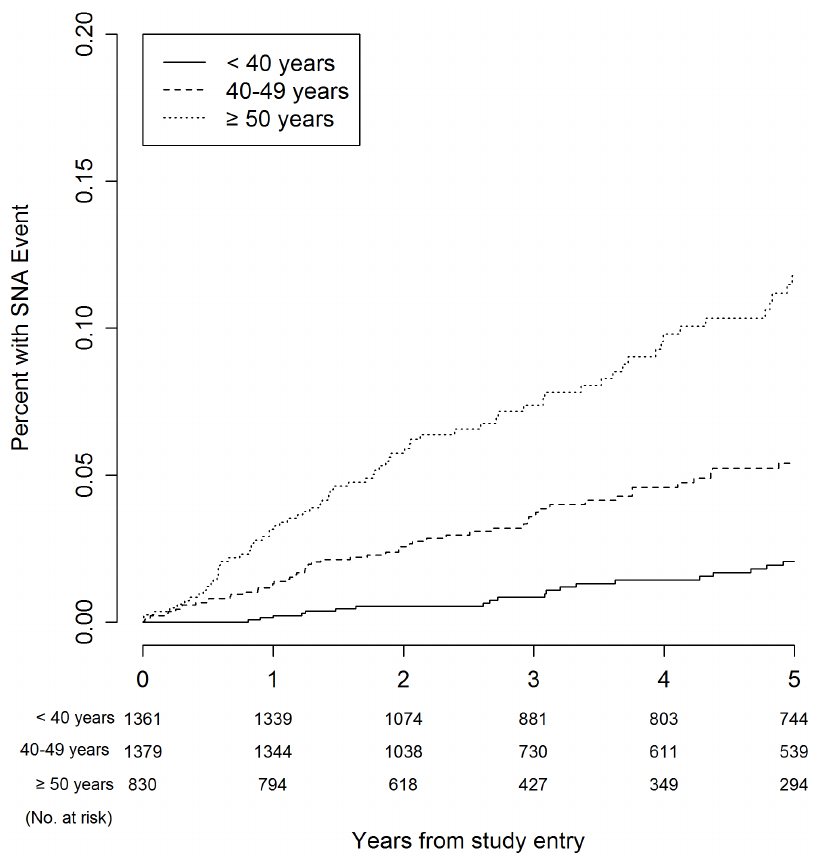
Figure 3. Cumulative probability of SNA event by age group.